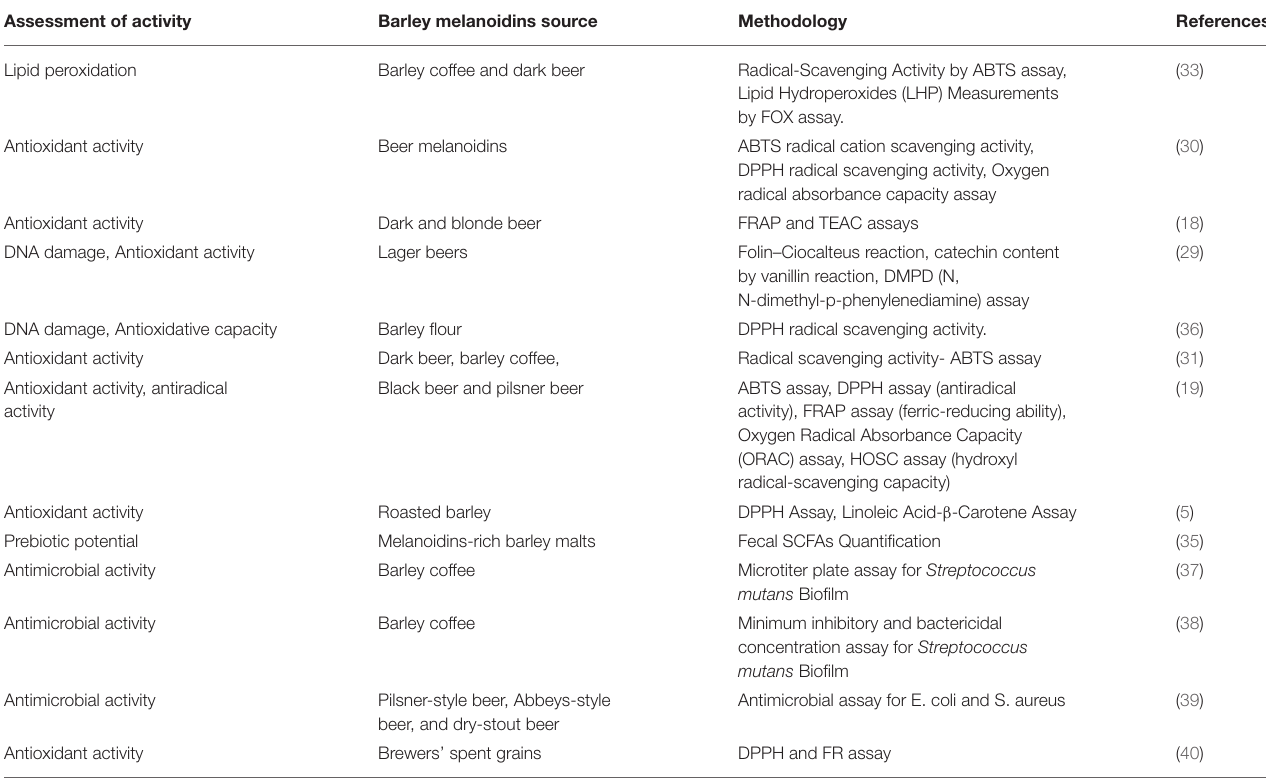
TABLE 2 | Methodology and source of melanoidins used in the assessment of biological